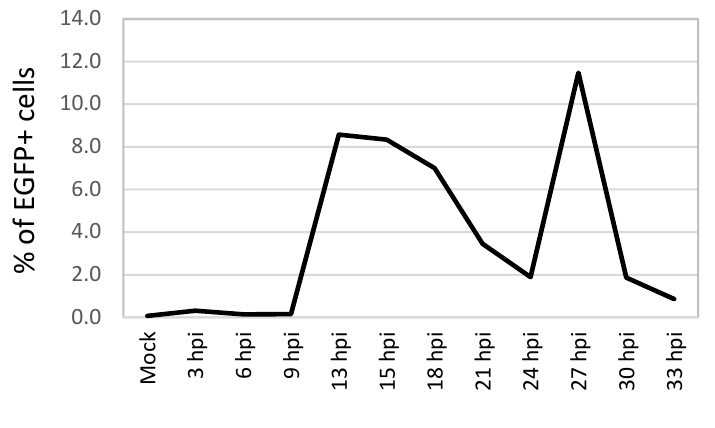
Figure 2. The percentages of EGFP+ monocytes and macrophages infected with 200 µ L of supernatants harvested at different hours post-infection from pig ex vivo adherent PBMC cultured in a 12-well plate and infected with MOI of 1 HAD 50 (the percentages were calculated based on flow cytometry analysis gated on the population containing monocytes and macrophages).